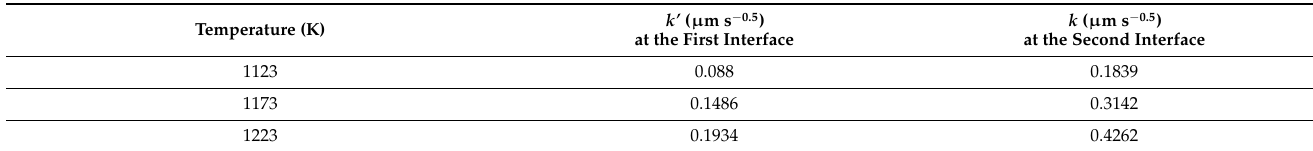
Table 3. Experimental parabolic growth constants deduced from the data of Figure 12.